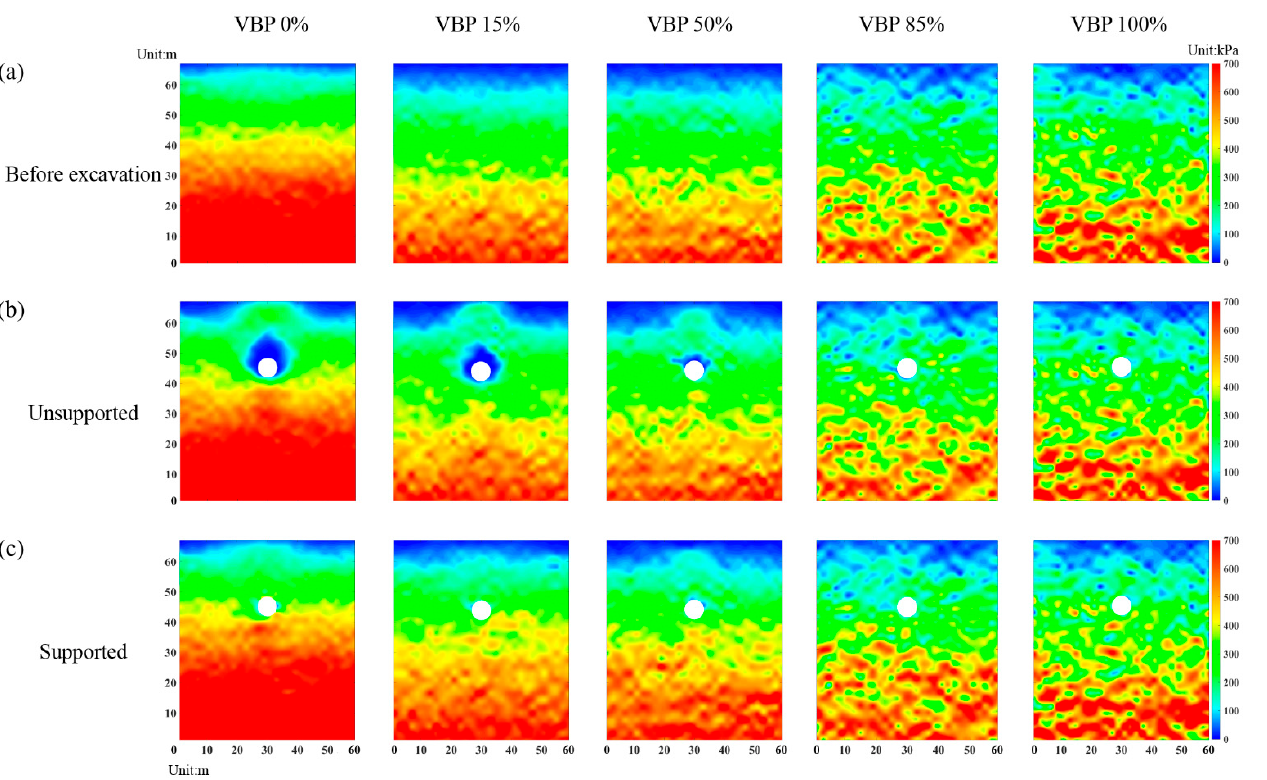
Figure 13. The distribution of vertical stresses in the computational domain: ( a ) initial state before excavation, ( b ) unsupported tunnel excavation, and ( c ) supported tunnel excavation by rigid lining.